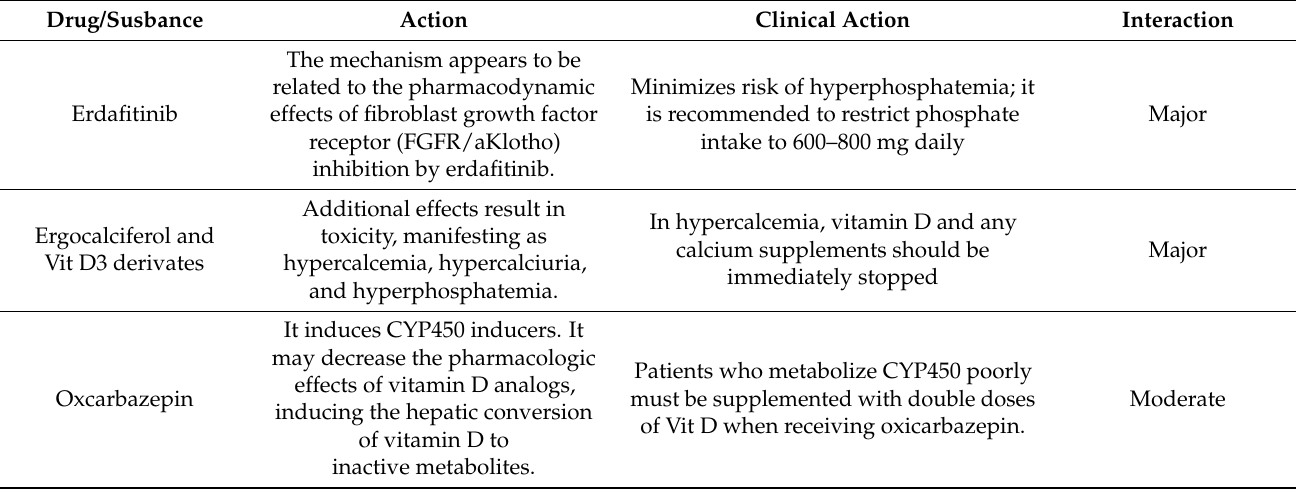
Table 2. Major and moderate drug interactions with vitamin D